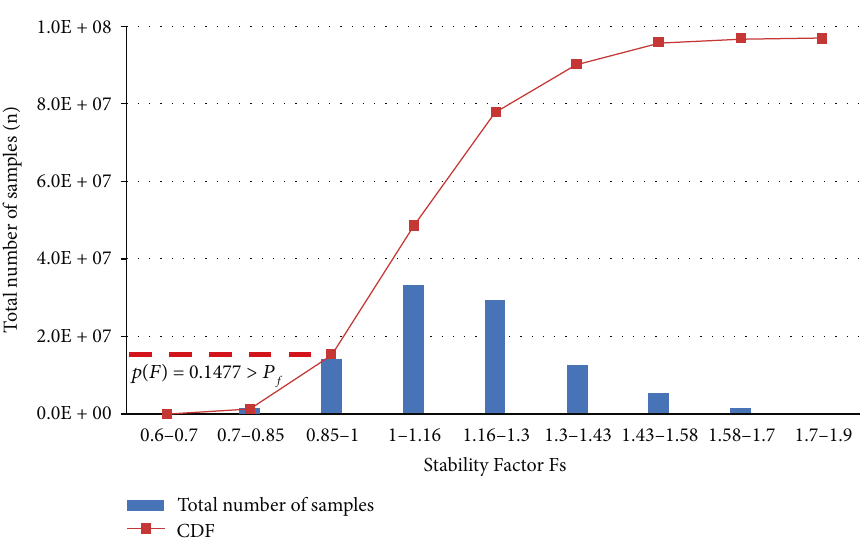
Figure 15: Statistical chart of slope stability coe ffi cient based on the MCS